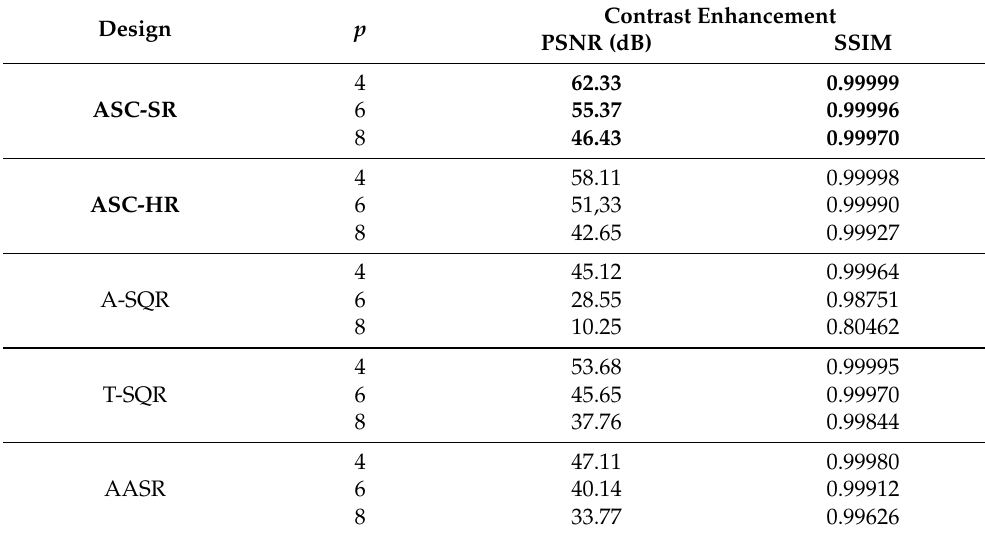
Table 4. Truth table of